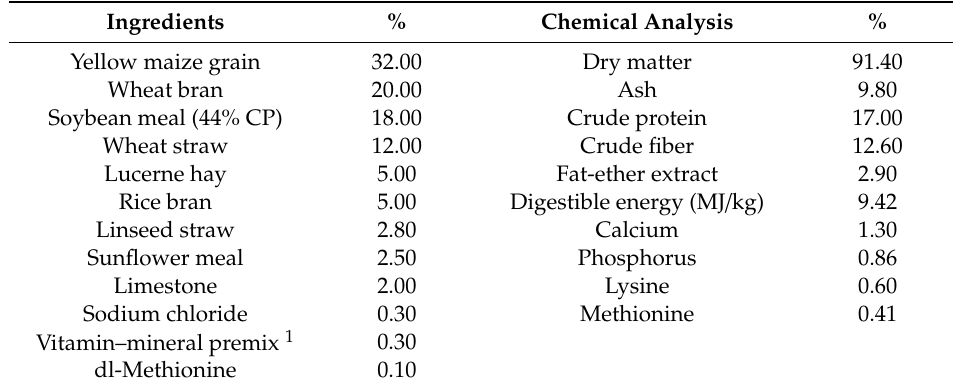
Table 1. Ingredients and chemical compositions (as-fed basis) of the control diet fed to rabbits throughout the experiment